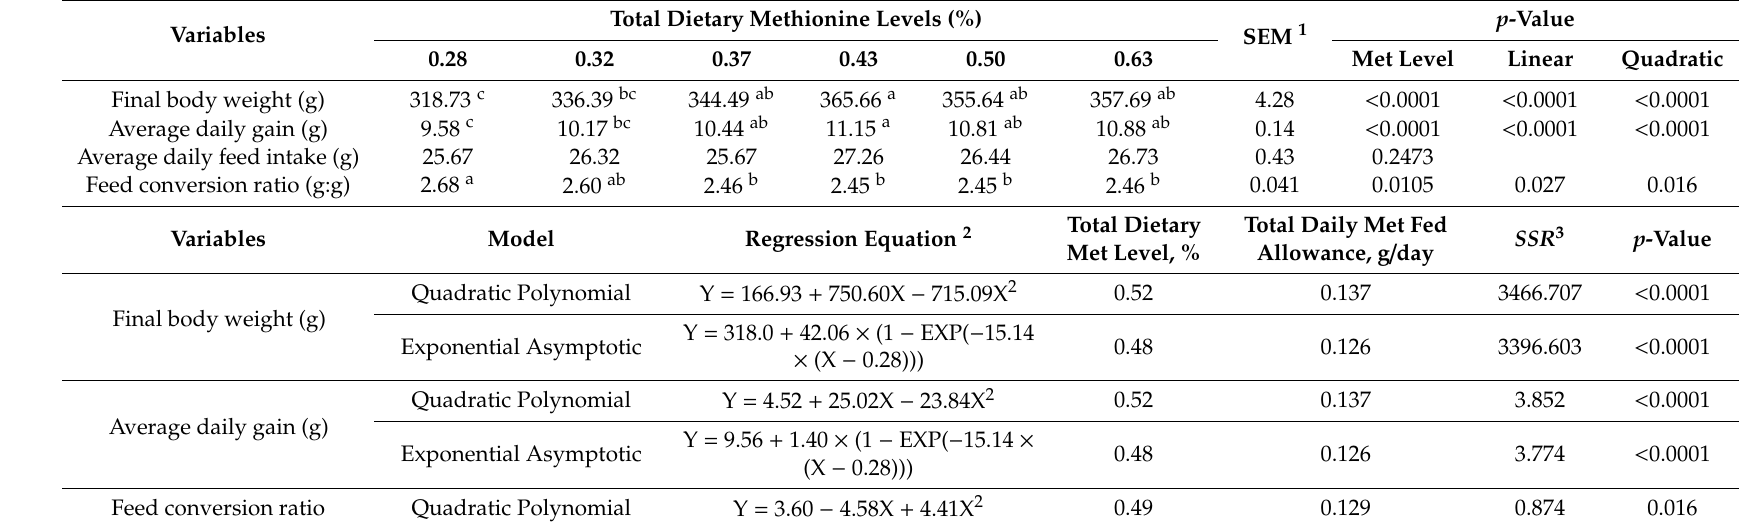
Table 7. E ff ects of total dietary methionine level on growth performance of mixed male and female Guangxi yellow-feathered chickens aged 1 to 30